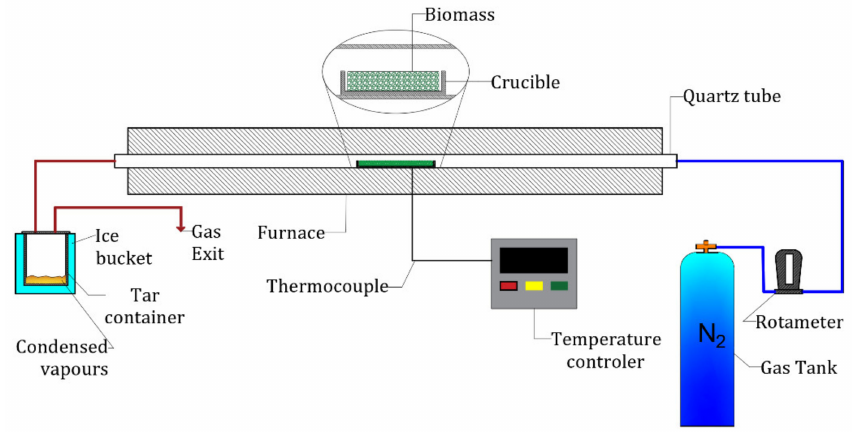
Figure 1. Laboratory setup